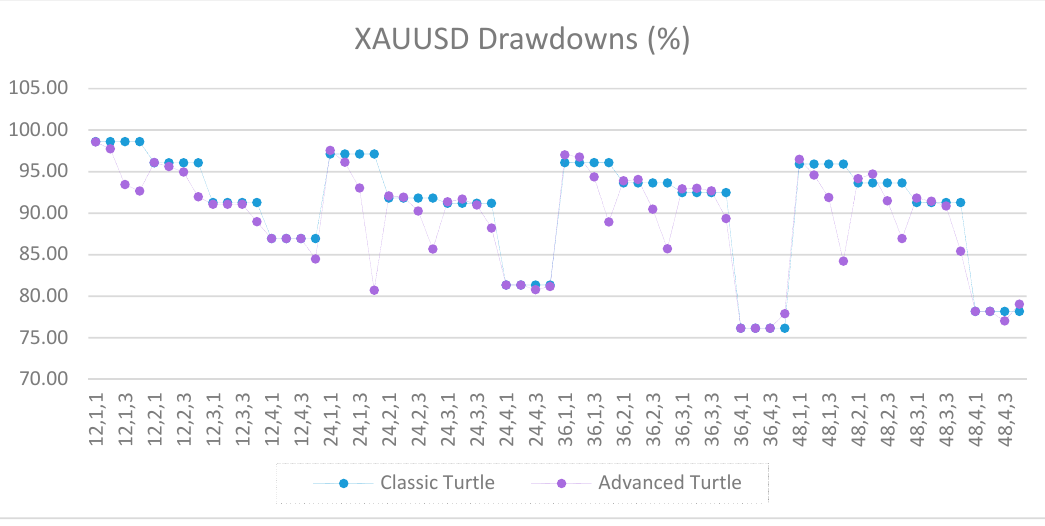
Figure A44. Drawdowns of XAUUSD as percentage of equity between the classic and the advanced Turtle systems for every combination of N, X, Y for the slow parameters (80, 160).